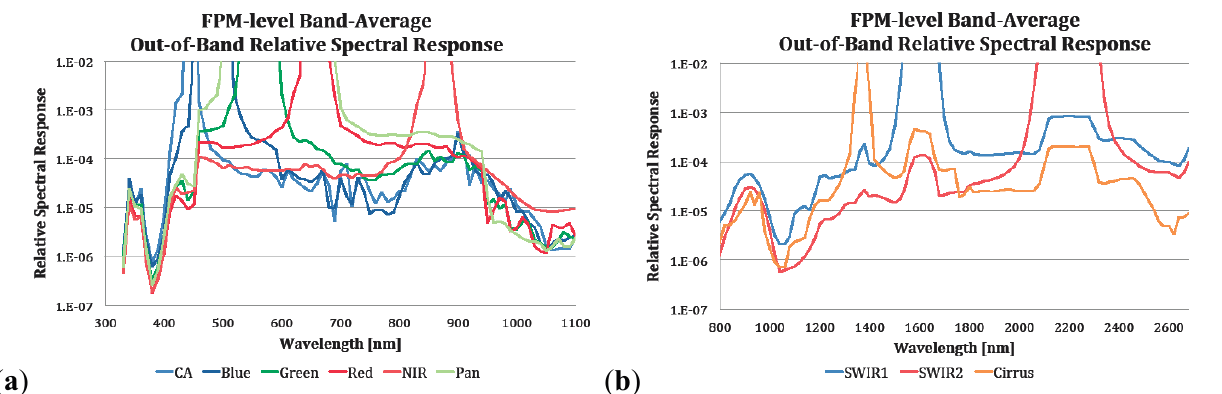
Figure 6. ( a ) OLI VNIR bands and ( b ) SWIR bands out-of-band response based on FPM-level measurements with other optical components (mirrors and FPA window) included analytically. The plots are scaled to show the out-of-band response, so the in-band response is not shown